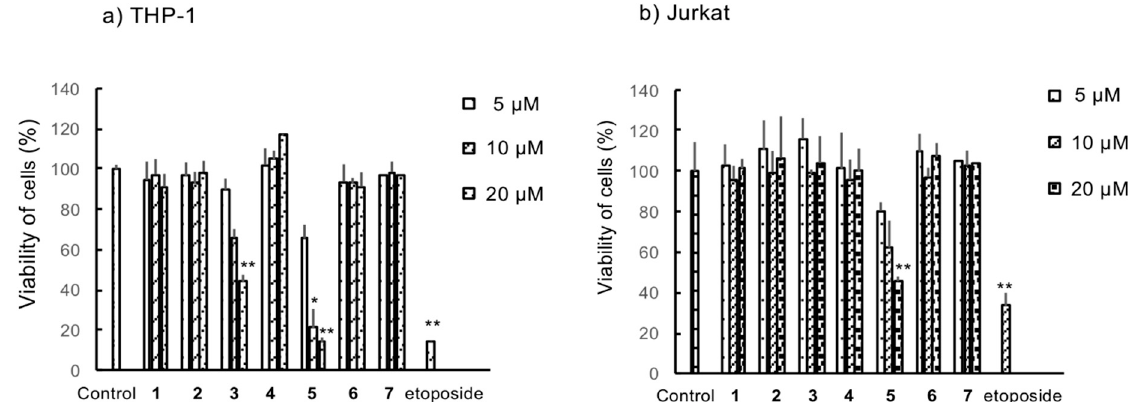
Figure 2. Cytotoxicity of compounds ( 1 – 7 ) in ( a ) THP-1 and ( b ) Jurkat cells. Cells were treated with the indicated concentrations of compounds for 24 h. Etoposide (1 µ M) was used as a positive control. Cell viability was determined by the WST-1 assay. Values are presented as the mean ± SD of three independent experiments. * p < 0.05, ** p < 0.01.